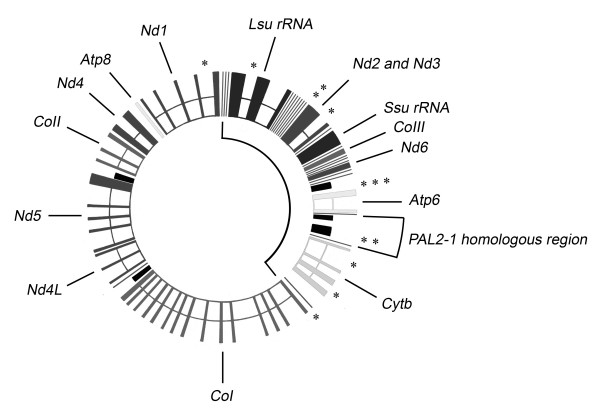
Integration sites of pAL2-1 homologues in the mitochondrial genome. Physical map of the ~100 Kb mitochondrial genome of P. anserina, indicating the location of plasmid integration sites (asterisks, see Table 1). Integration sites are clustered (Rayleigh's test Z = 6.59, df = 1, P < 0.001; Rao's spacing test U = 188.38, df = 1, P < 0.001). The region affected by integration approximately corresponds to the 37 Kb region that is deleted in 'premature death' strains (indicated in the inner circle). The same region contains a sequence with homology to pAL2-1.